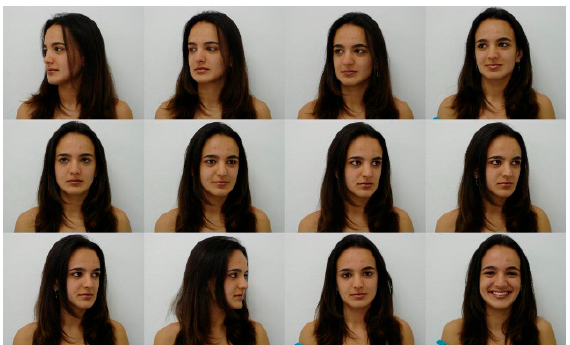
Figure 15. Example of images (FEI face database).